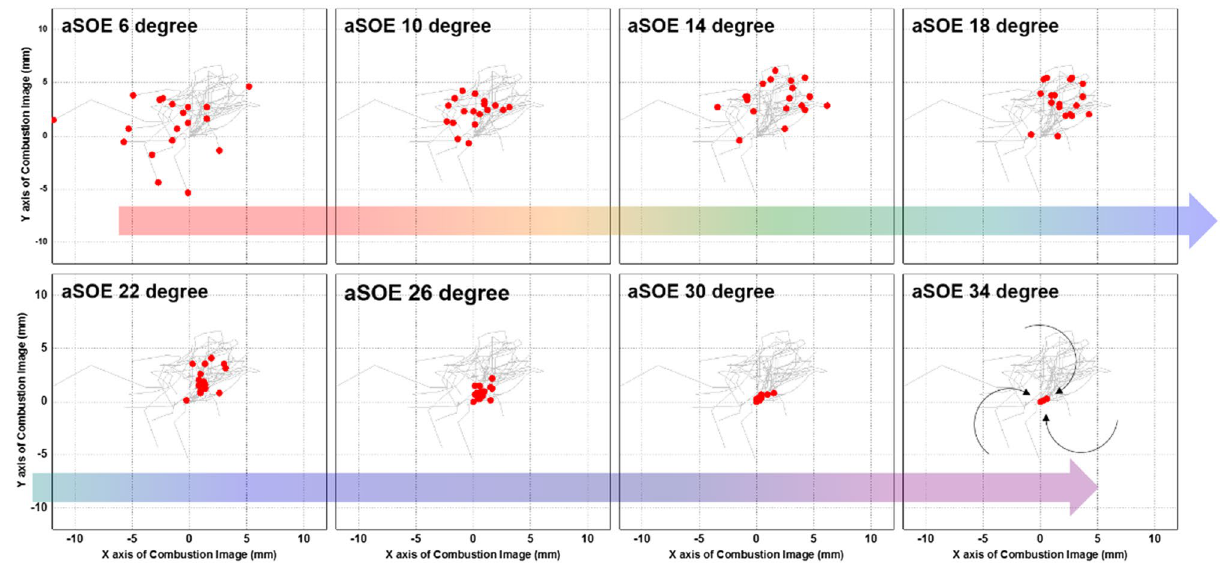
Figure 18. Variation of central coordinates of the flame surfaces in the MPDF combustion.